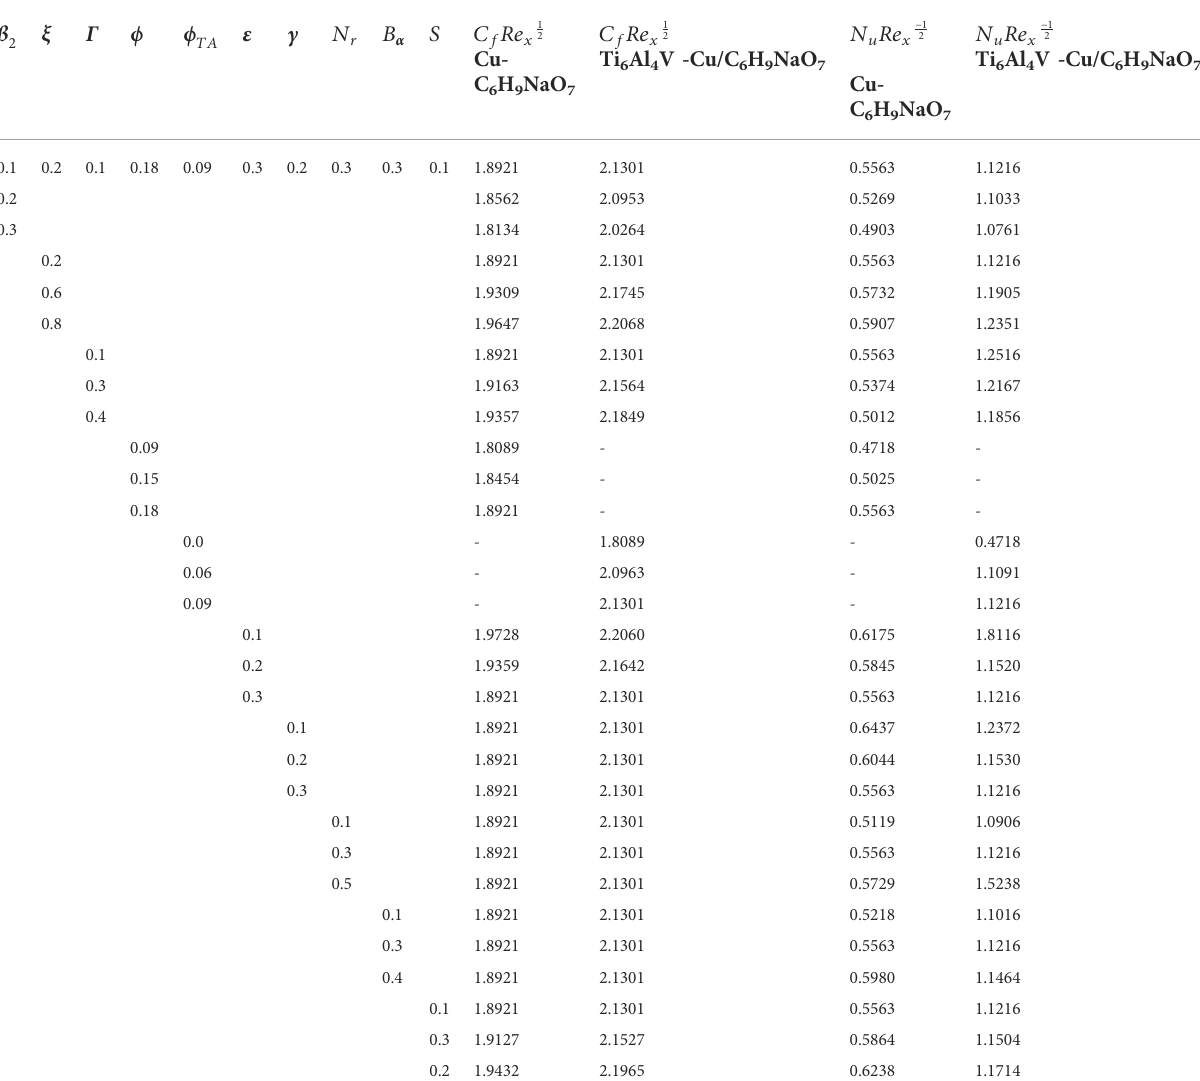
TABLE 7 C f Re x 1 2 and N u Re x − 1 2 values at P r (cid:2) 6 . 5, β 1 (cid:2) 0 . 01 and m (cid:2) 3. β